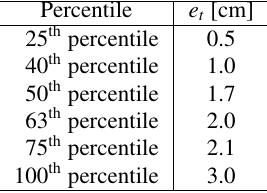
Table 1. Percentiles of localisation translation errors according to the empirical